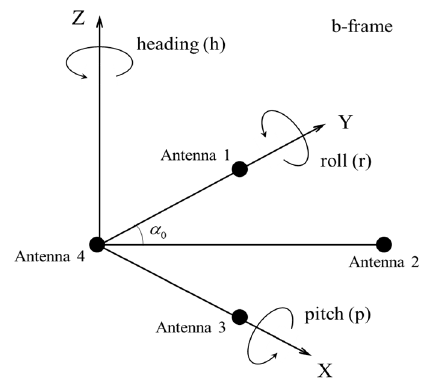
Figure 1. Schematic diagram of four-antenna.